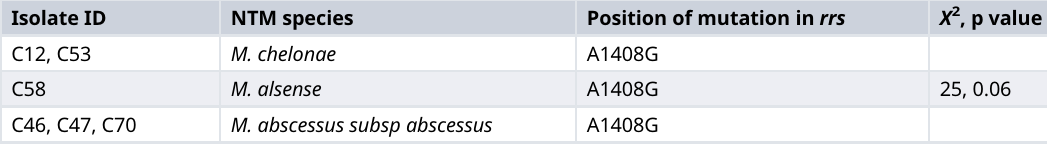
Table 4. Rapid-growing NTM showing mutations associated with aminoglycoside resistance.